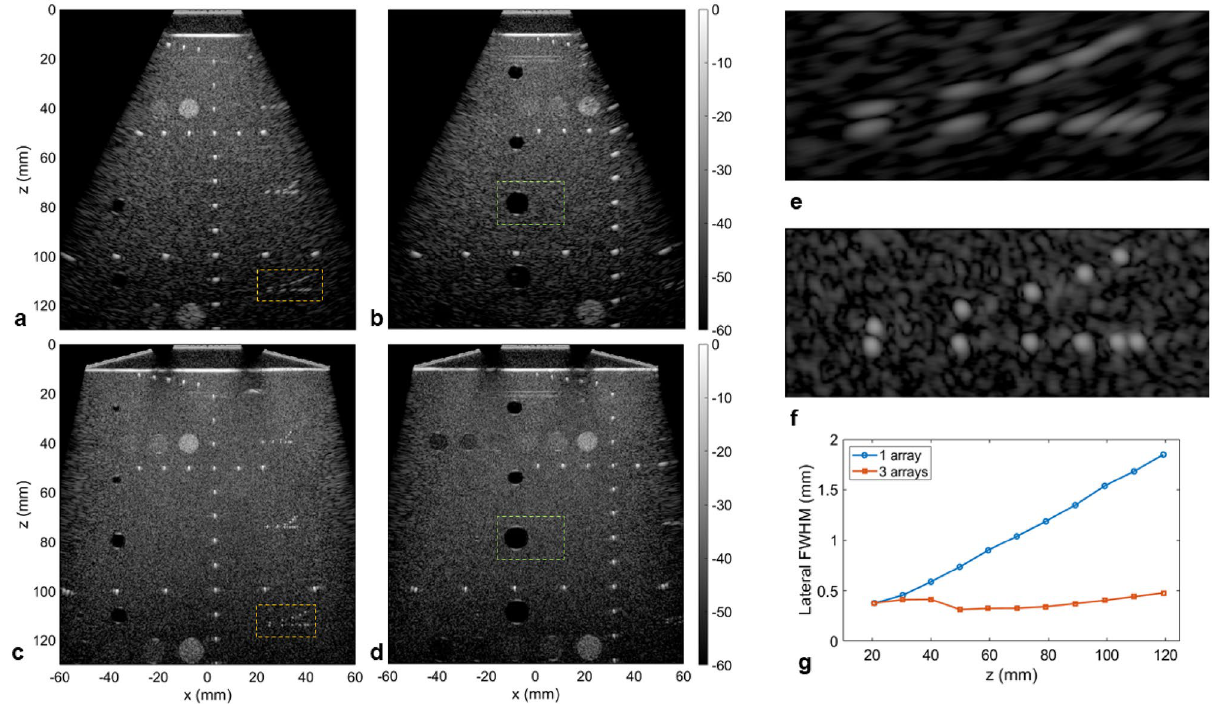
Figure 3. Extended aperture imaging on a calibrated commercial phantom (CIRS 054GS). ( a – d ). Images of the phantom utilizing only the central array (( a ) above the wire targets; ( b ) above the hypoechoic cysts) or all three arrays (( c ) above the wire targets; ( d ) above the hypoechoic cysts) for 91 plane waves (− 30° to 30°). ( e , f ) The expanded view of the deeper set of wire targets (orange rectangle in ( a ) and ( c ), located at a depth of 110 mm) shows the significant improvement in term of lateral resolution going from one array ( e ) to 3 arrays ( f ). The dynamic range is 60 dB for all images. Note that an agar/glycerol phantom standoff (speed of sound 1540 m/s) is inserted between the array assembly and the top surface of the phantom. ( g ) Comparison of the lateral resolution (full-width at half maximum) as a function of depth for the set of wires located at the center of ( a ) and ( c